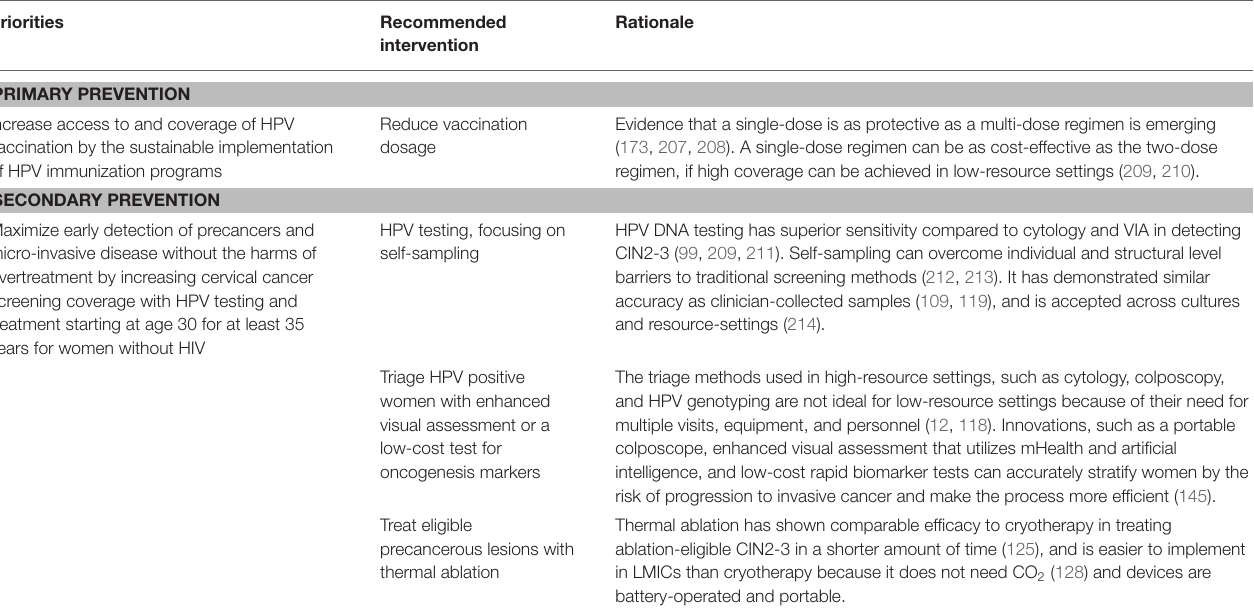
TABLE 6 | Innovative technologies and approaches that may be appropriate for comprehensive prevention